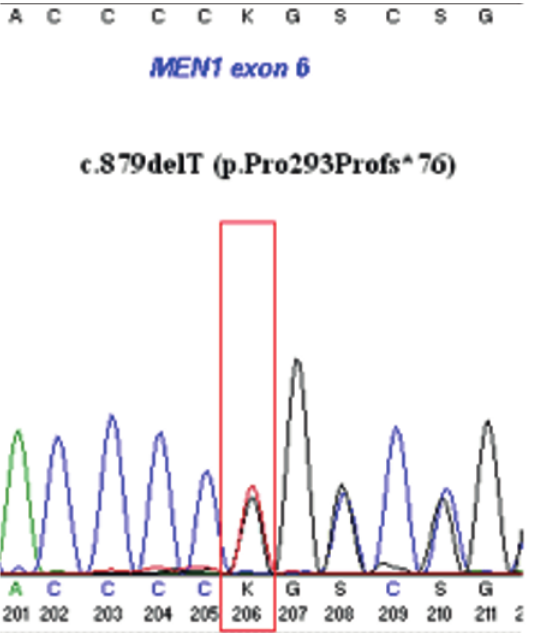
Figure 3. Sequence analysis of MEN1 gene showing heterozygous mutation c.879delT (p.Pro293Profs*76).